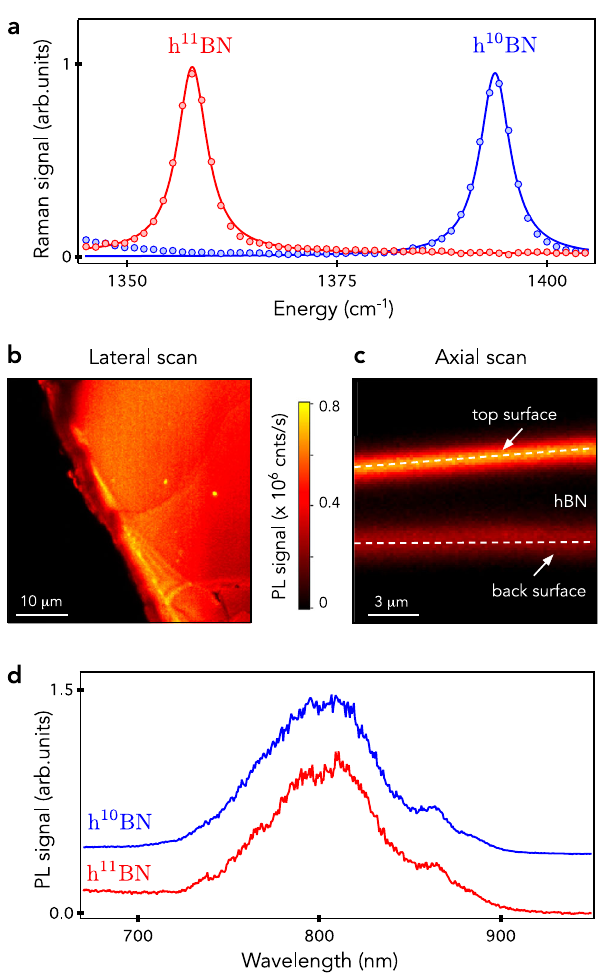
Fig. 1 Optical properties of neutron-irradiated monoisotopic hBN crystals. a Raman scattering spectra recorded at room temperature on the h 11 BN (red dots) and h 10 BN crystals (blue dots) after neutron irradiation. The solid lines are data fi tting with Lorentzian functions. b Typical lateral PL raster scan of the h 10 BN crystals under green laser illumination with a power of 1 mW. c Axial confocal scan showing a high PL signal localized at the crystal surfaces. d PL spectra recorded from the h 11 BN (red) and h 10 BN crystals (blue). The data have been normalized and vertically shifted for the sake of clarity.